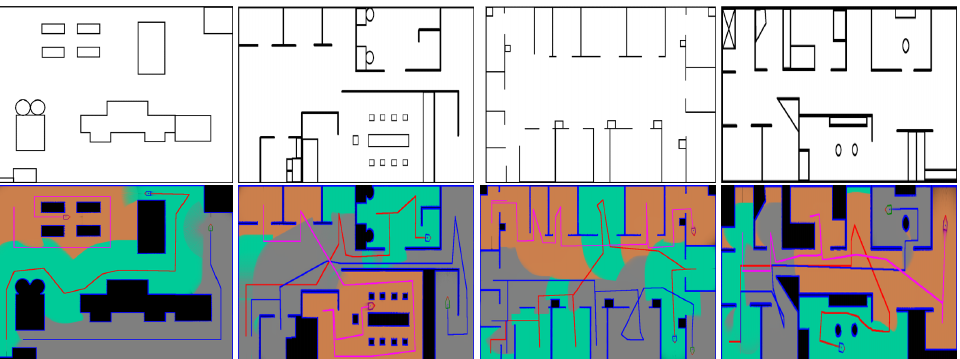
Figure 6. An example of the exploration process using the proposed multi-robot CCPP algorithm. The figures indicate that the high coverage gain is an important criterion for the robot movement.